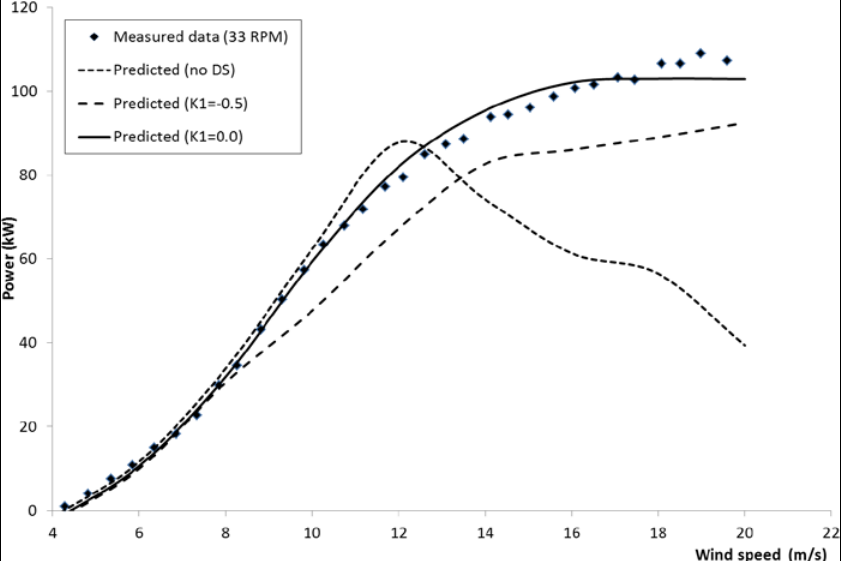
Figure 10. VAWT-260 H-rotor power vs. wind speed at 33